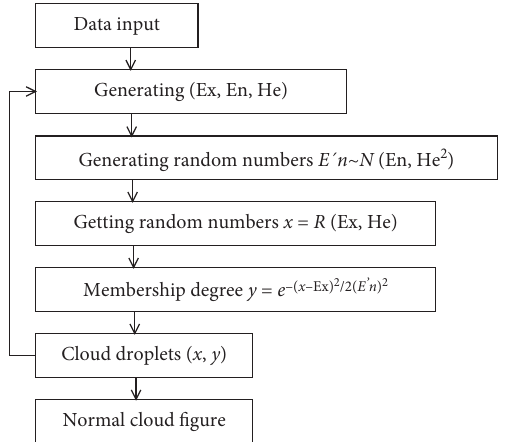
Figure 2: Operation of the forward cloud